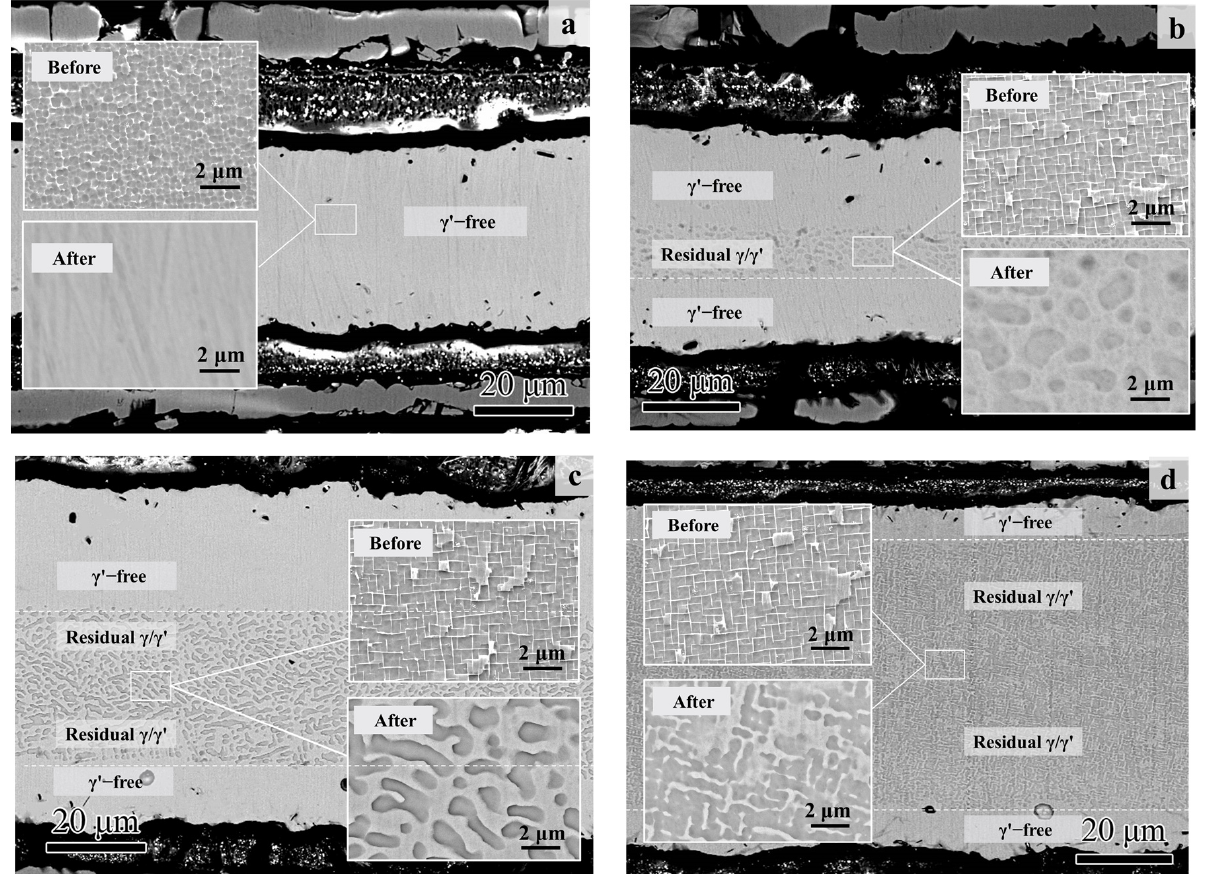
Figure 8. Cross − section morphologies of the thin specimens (thickness of 0.1 mm) with different original Al contents after 100 h of isothermal oxidation at 1100 °C: ( a ) S01 − 1; ( b ) S01 − 2; ( c ) S01 − 3; ( d ) S01 − N. The magnified morphologies in the core are shown as inner figures in order to reveal the microstructure degradation more clearly. The original microstructures before oxidation are also shown for comparison.